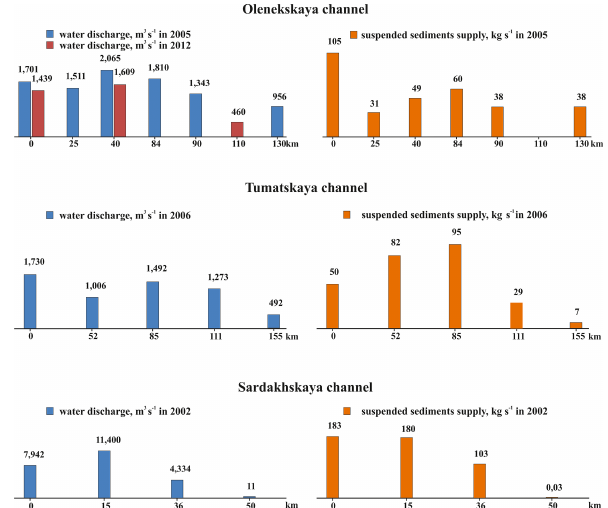
Figure 6. Discharge of water and sediments along the branches: on the Olenekskaya branch during 2005 and 2012, on the Tu- matskaya branch during 2006, and on the Sardakhskaya branch during 2002. The distance of the measurement cross-section from the standard hydrometeorological cross-sections of Roshydromet is shown on the x -axis. The position of the standard hydrometeoro- logical cross-sections of Roshydromet on the branch (cross-section near Gogolevsky Island for the Sardakhskaya branch) is taken as